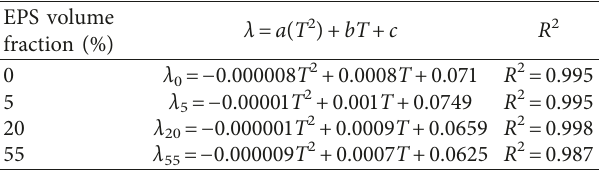
Table 6: Empirical correlations of thermal conductivity and temperature ( T ).